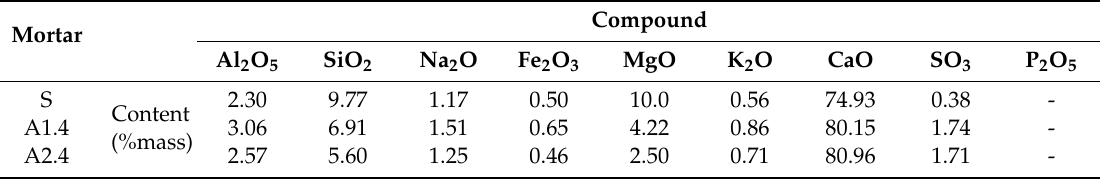
Table 9. The chemical composition of the standard and hydrophobized lightweight.